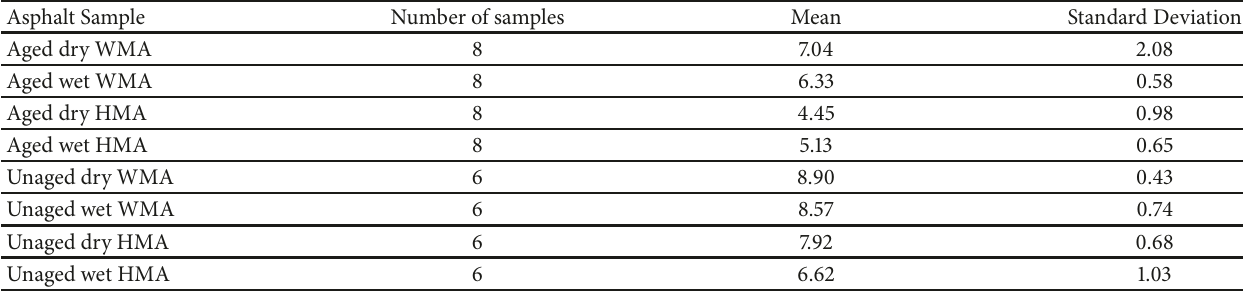
Table 3: Sample means and sample standard deviations of samples according to combinations of age, moisture, and temperature.